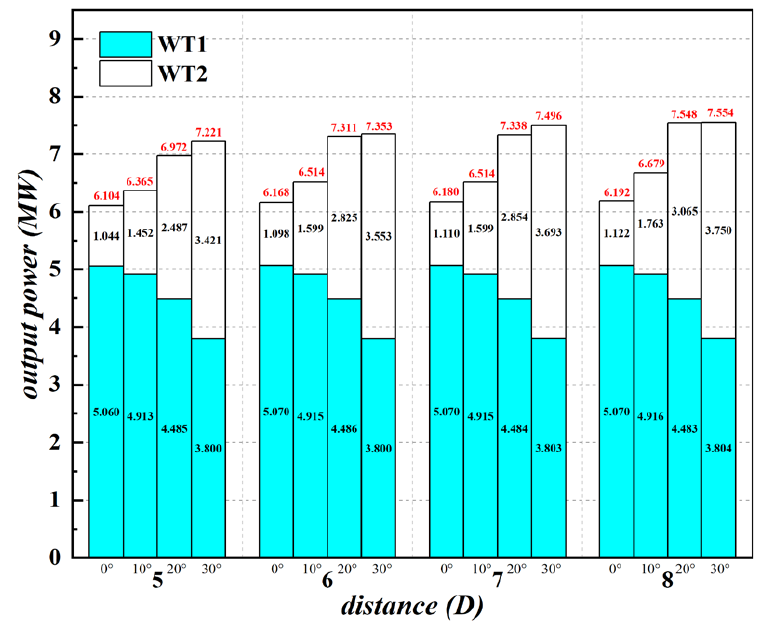
Figure 9. Average output power of the